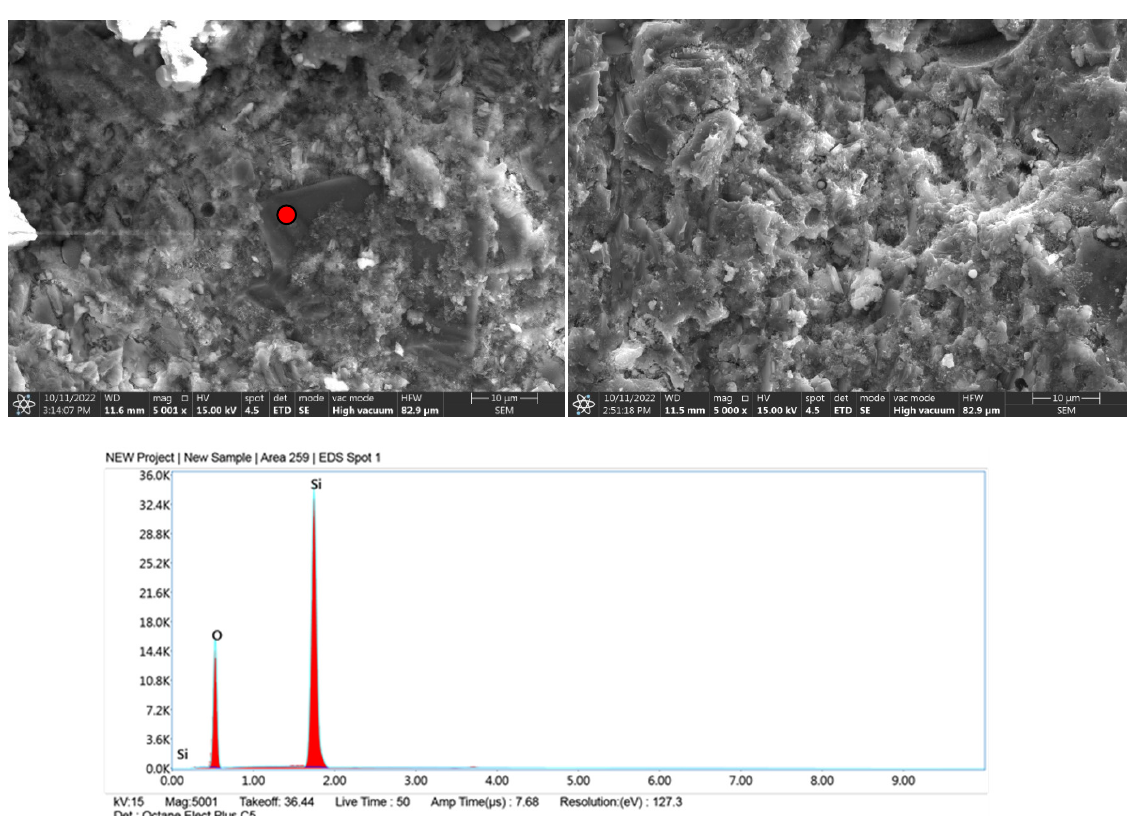
Figure 10. Microphotographs with EDS analysis of sample with granite powder after 5 h grinding.